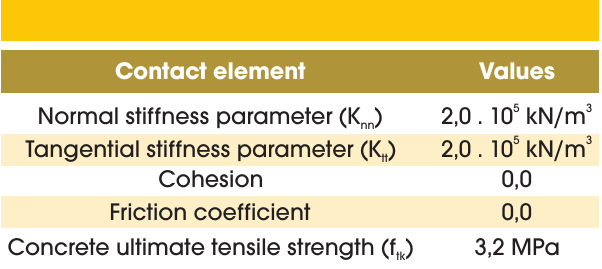
Table 5 – Contact elements properties